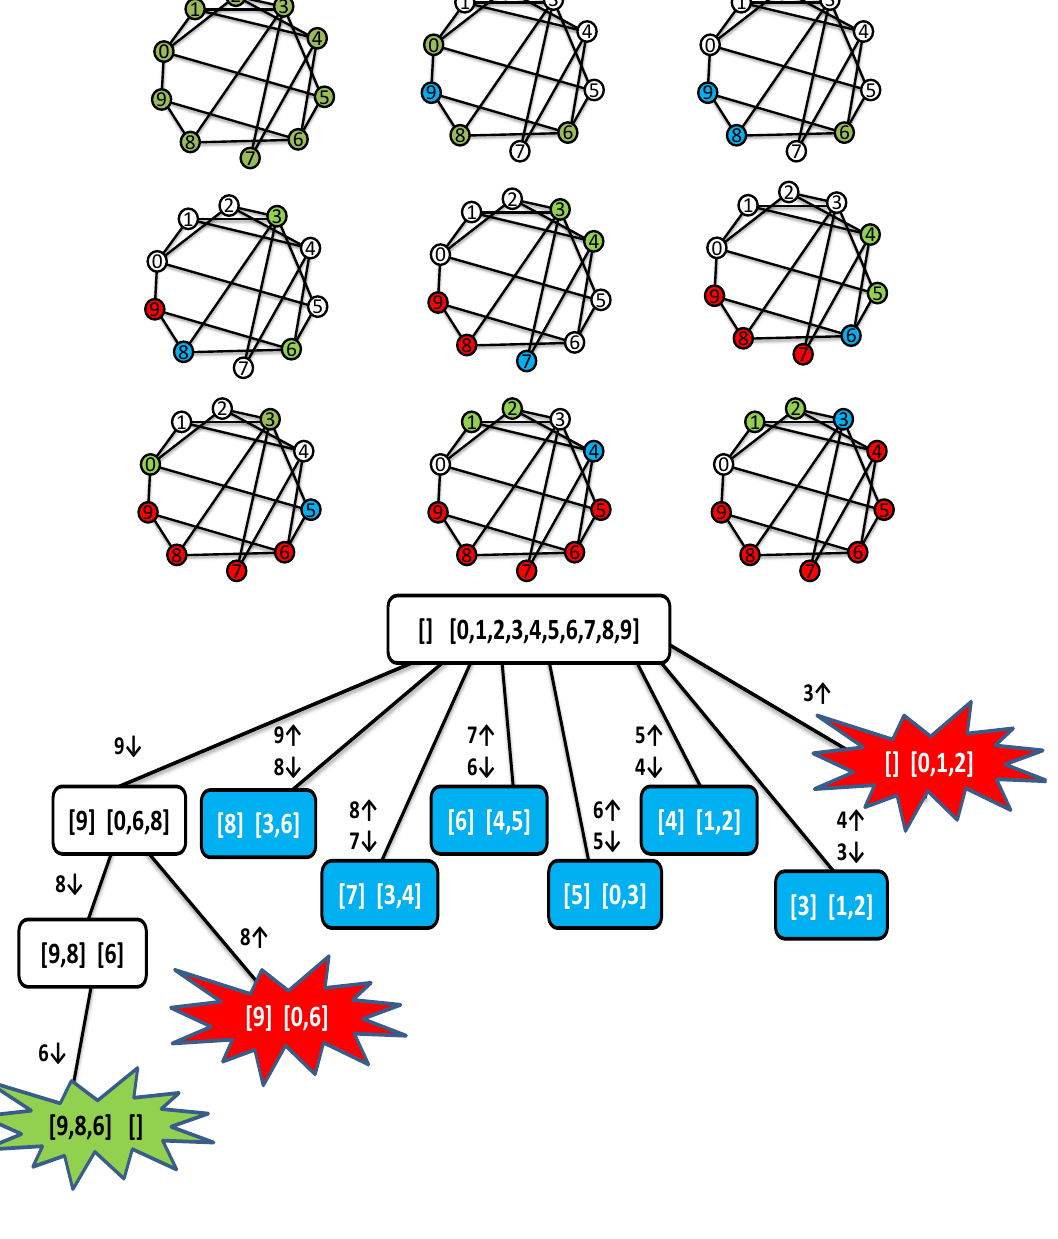
Figure 3. Cartoon, trace and backtrack-tree for MC on graph